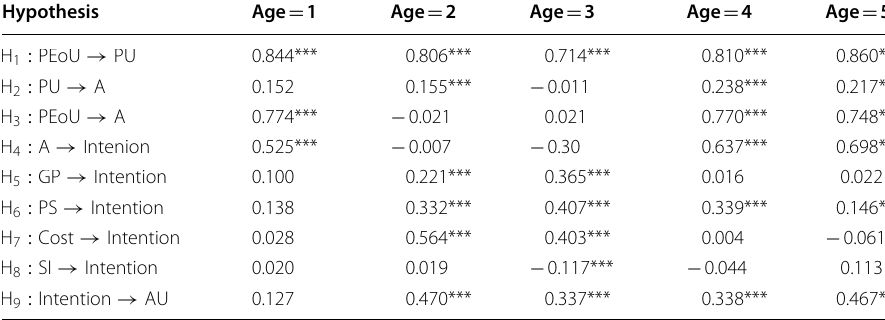
Table 8 The impact of age on e-cash use Hypothesis